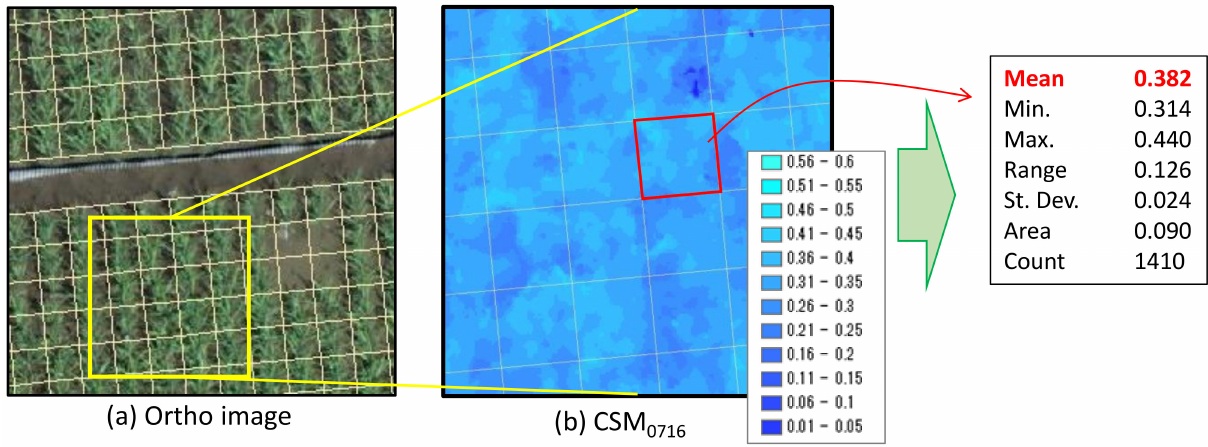
Figure 8. Canopy height calculation from ( a ) ortho image and ( b ) CSM in a 30 × 30 cm area covering two